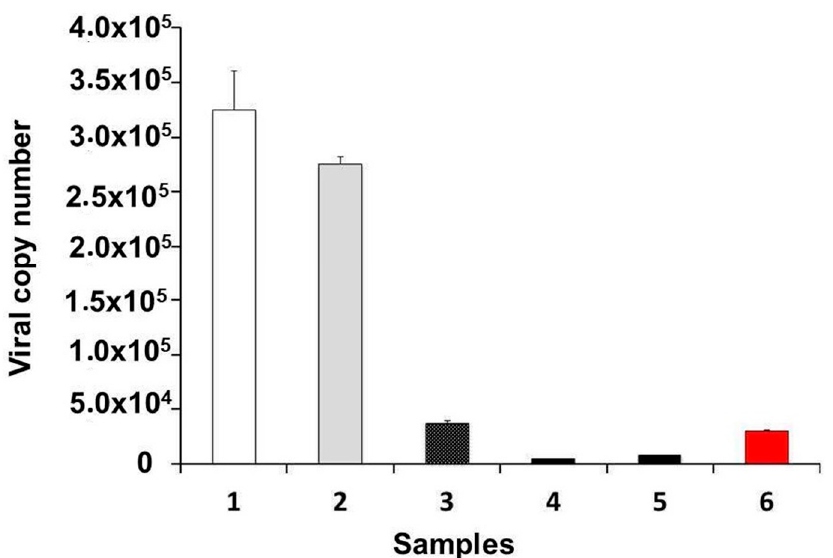
Figure 6. Filtering effect of textiles coated with GO. q-RT PCR on U 373 cells infected with HHV-6A. The virus was allowed to infect cells after passing through different filters. Values are mean of n . 1 :